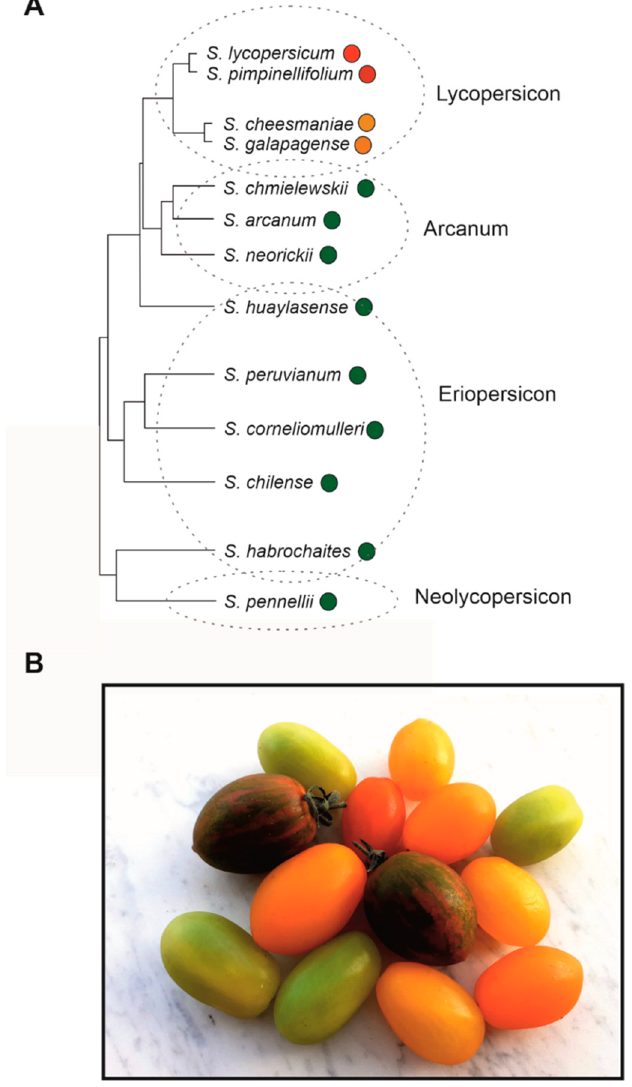
Figure 2. ( A ) Phylogenetic tree of Solanum species belonging to the tomato clade, divided in the four subgroups identified by [27,28]. Redrawn with simplifications from [29], with the addition of the fruit colour, represented by coloured circles close to the species names. ( B ) Photo of a group of ripe Solanum lycopersicum fruits exhibiting possible colour variants in the carotenoid/chlorophyll pathway: red, orange, yellow, green, and “green stripe”-like colourations are shown.